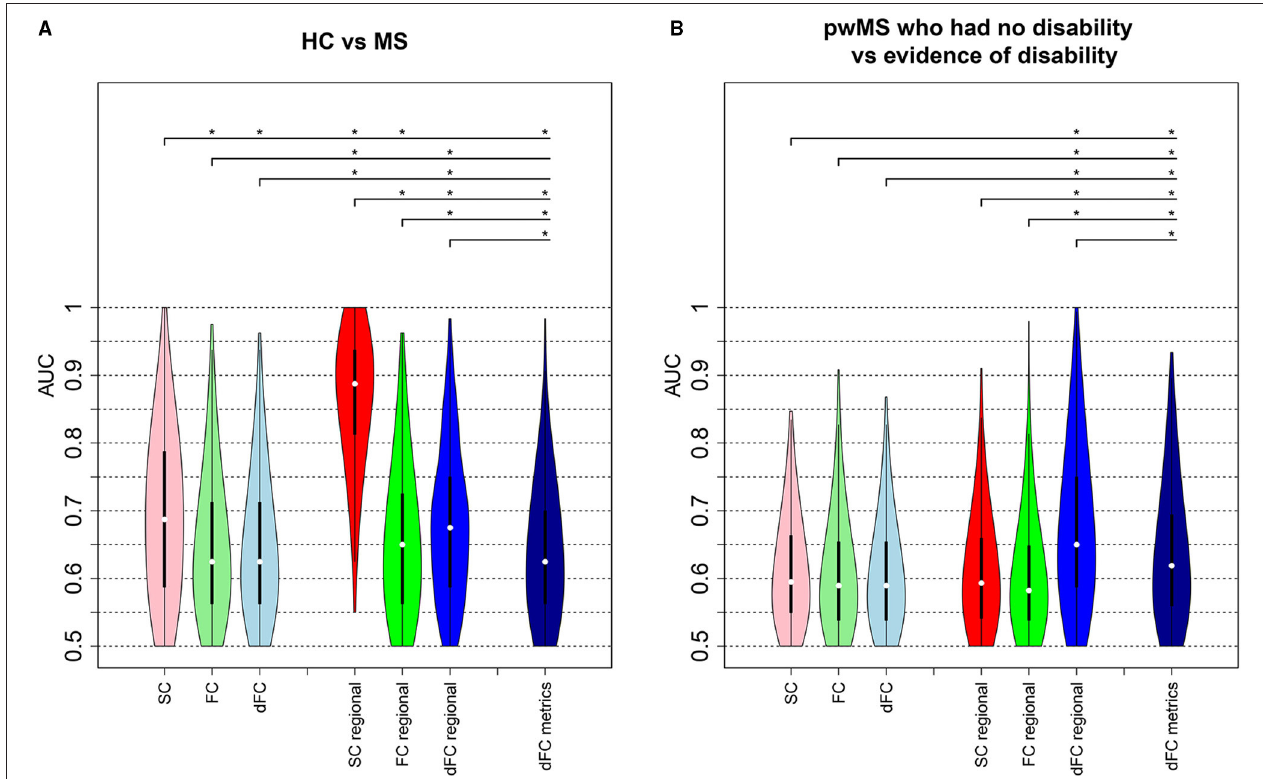
FIGURE 3 | Classification analysis results. AUC values obtained from the models classifying (A) HC vs. pwMS and (B) pwMS according to their disability level. The first three violin plots show the AUC results from the models including pairwise connectivity information. The number of the imaging variables was 3,655 for pairwise SC and FC, while 14,620 (= 3655 × 4 dFC states) variables included in the pairwise dFC model. The next set of three violin plots show the AUC values from the regional models where regional SC and FC models each included 86 imaging variables and the regional dFC model included 344 (= 86 × 4 dFC states) imaging variables. The last model that included dFC metrics contained 21 imaging variables. The plots show the median (white dot), 1st and 3rd quartiles (black bar) over the 500 hold-out test sets. Asterisks indicate significant differences ( p < 0.05, BH corrected) in the distribution of AUC values between different